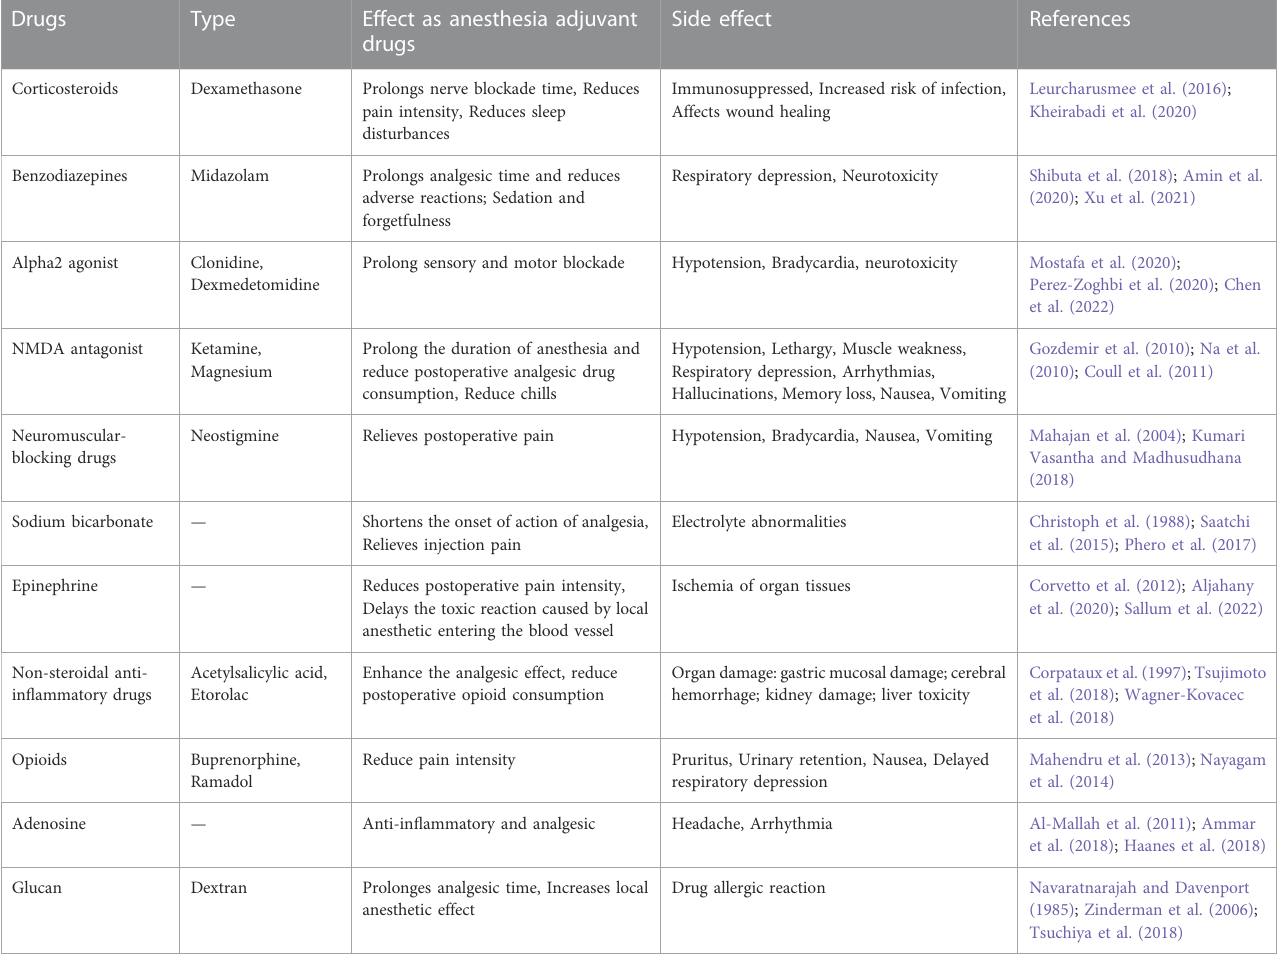
TABLE 1 Effectiveness and potential side effects of anesthetic